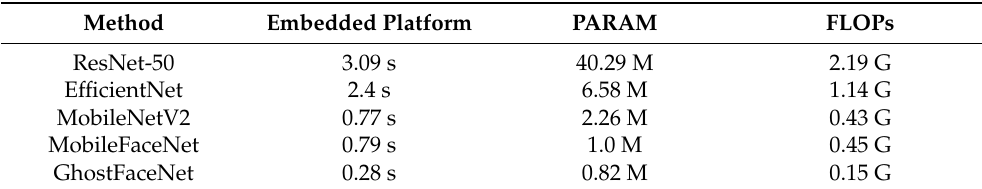
Table 13. Speed comparison of GhostFaceNet with different models for single image recognition in embedded